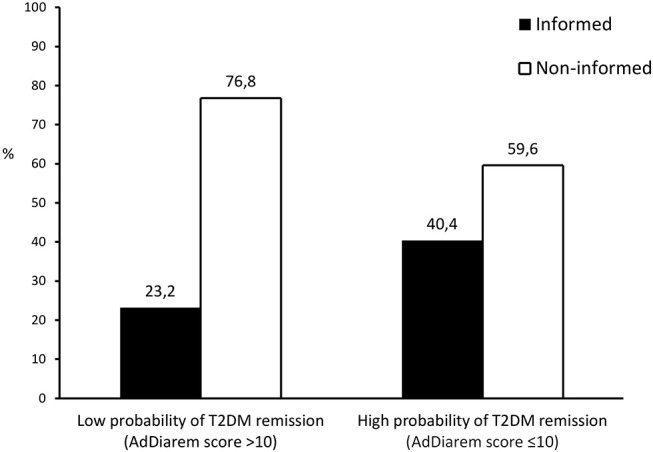
Graphical presentation of the percentage of patients having been informed about the treatment option of metabolic surgery among those with high vs. low probability of T2DM remission within the first 5 years following bariatric surgery, stratified according to the advanced DiaRem[[Inline Image]] score. AdDiarem score, advanced diabetes remission score; T2DM, type 2 diabetes mellitus.